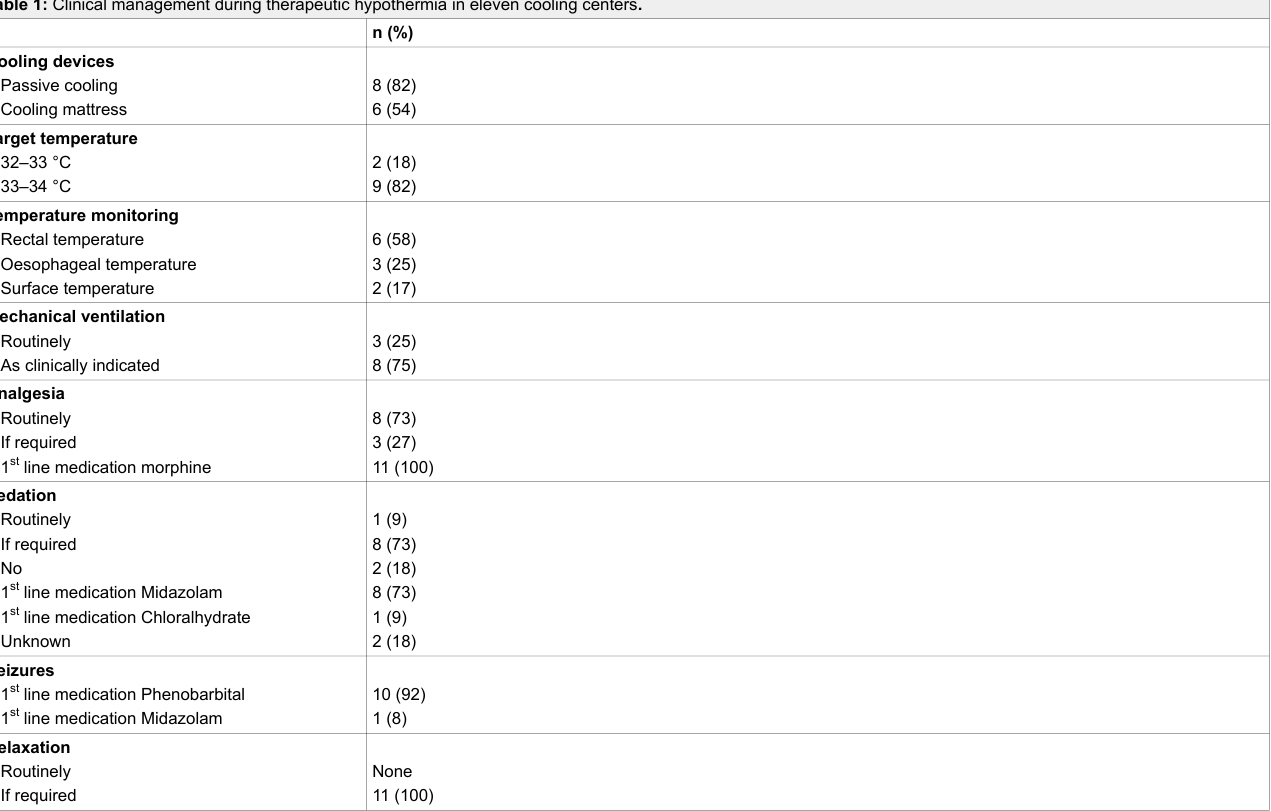
Table 1: Clinical management during therapeutic hypothermia in eleven cooling centers .